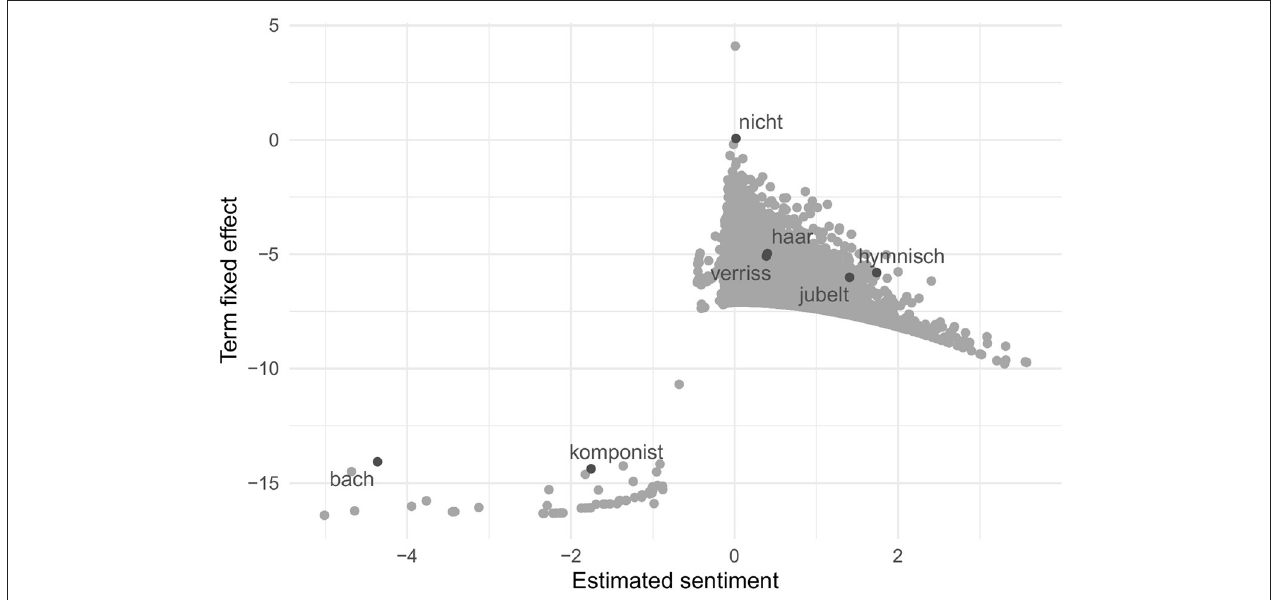
FIGURE 3 | Sentiment of words estimated by unsupervised